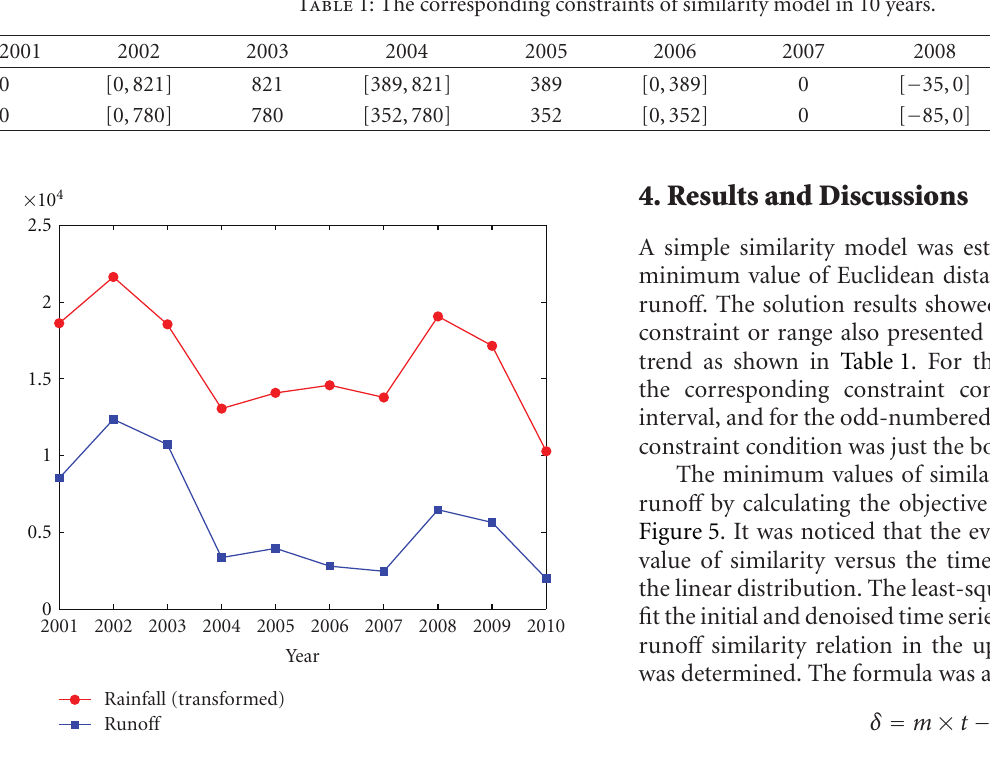
Figure 4: The runo ff and transformed rainfall